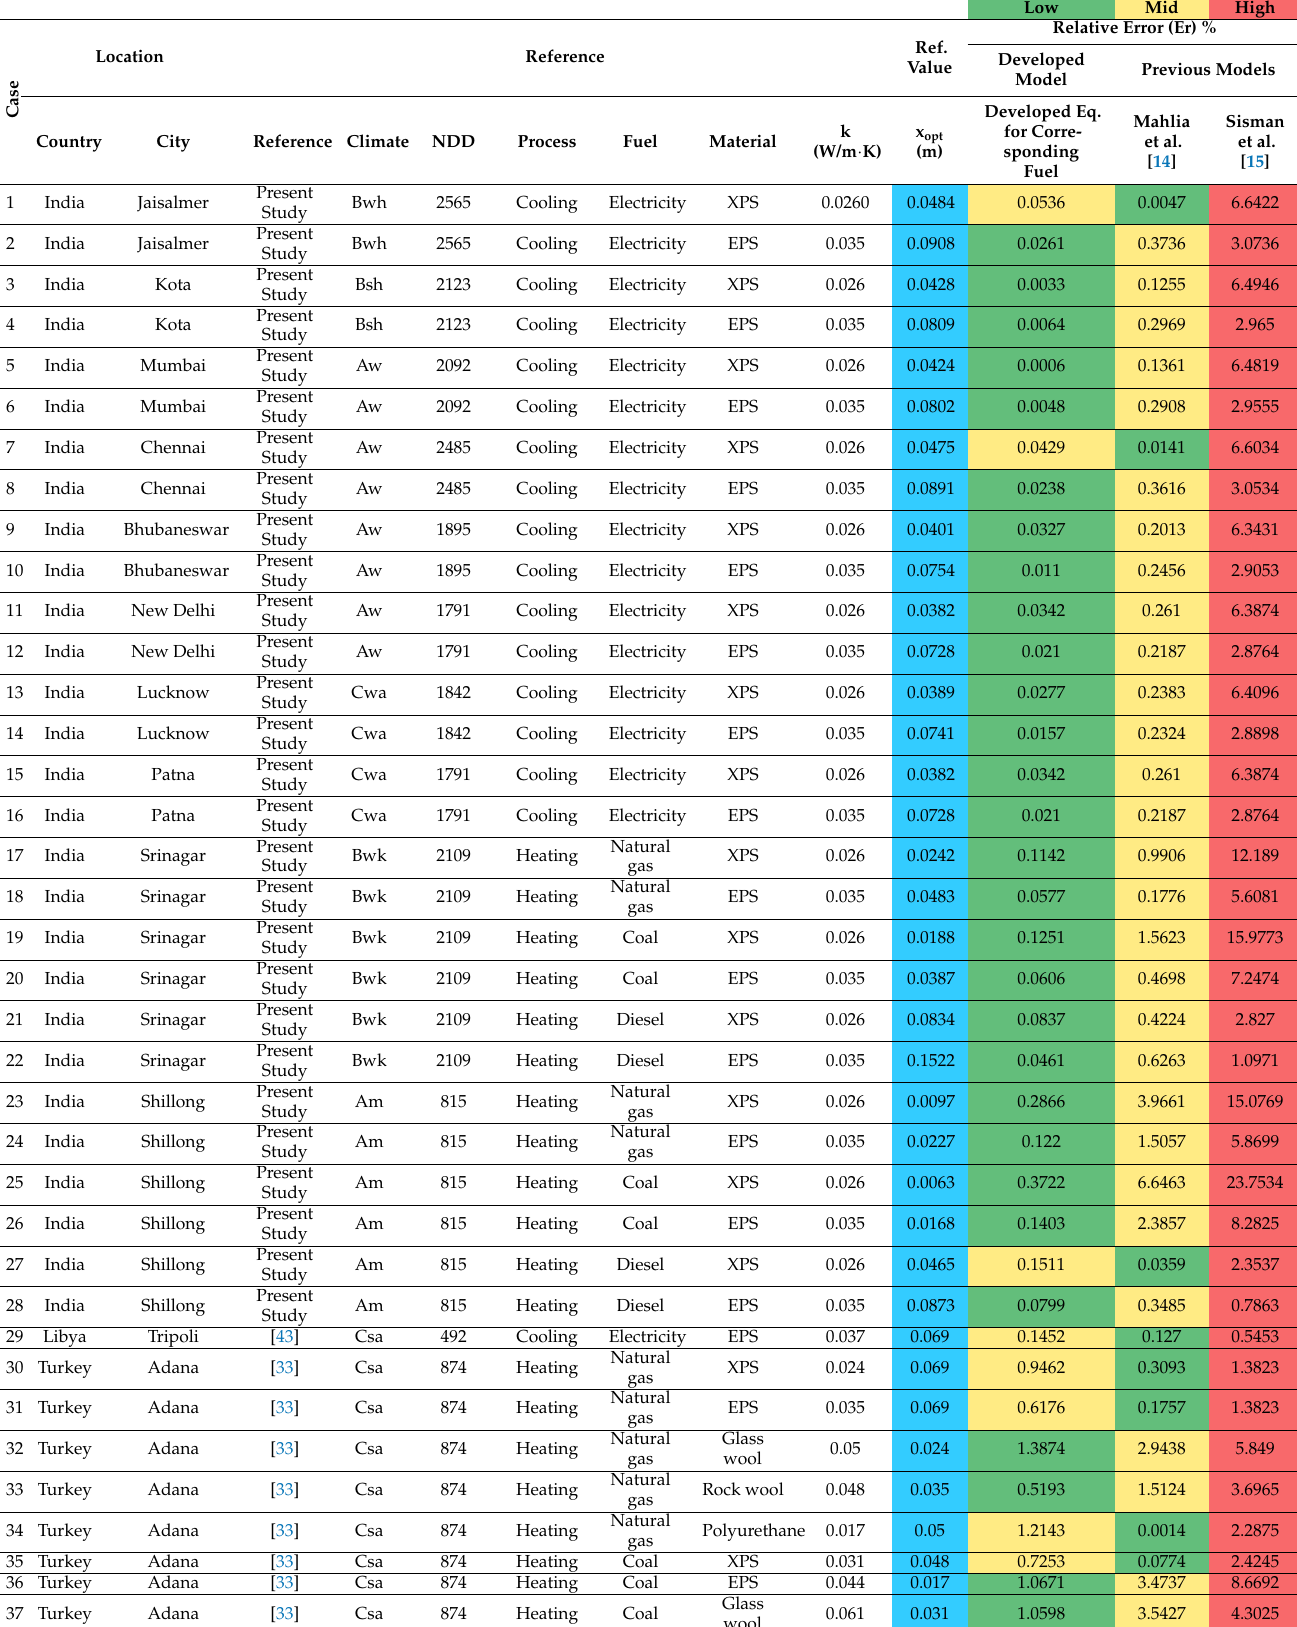
Table 7. Relative error statistical results of reference results with estimated